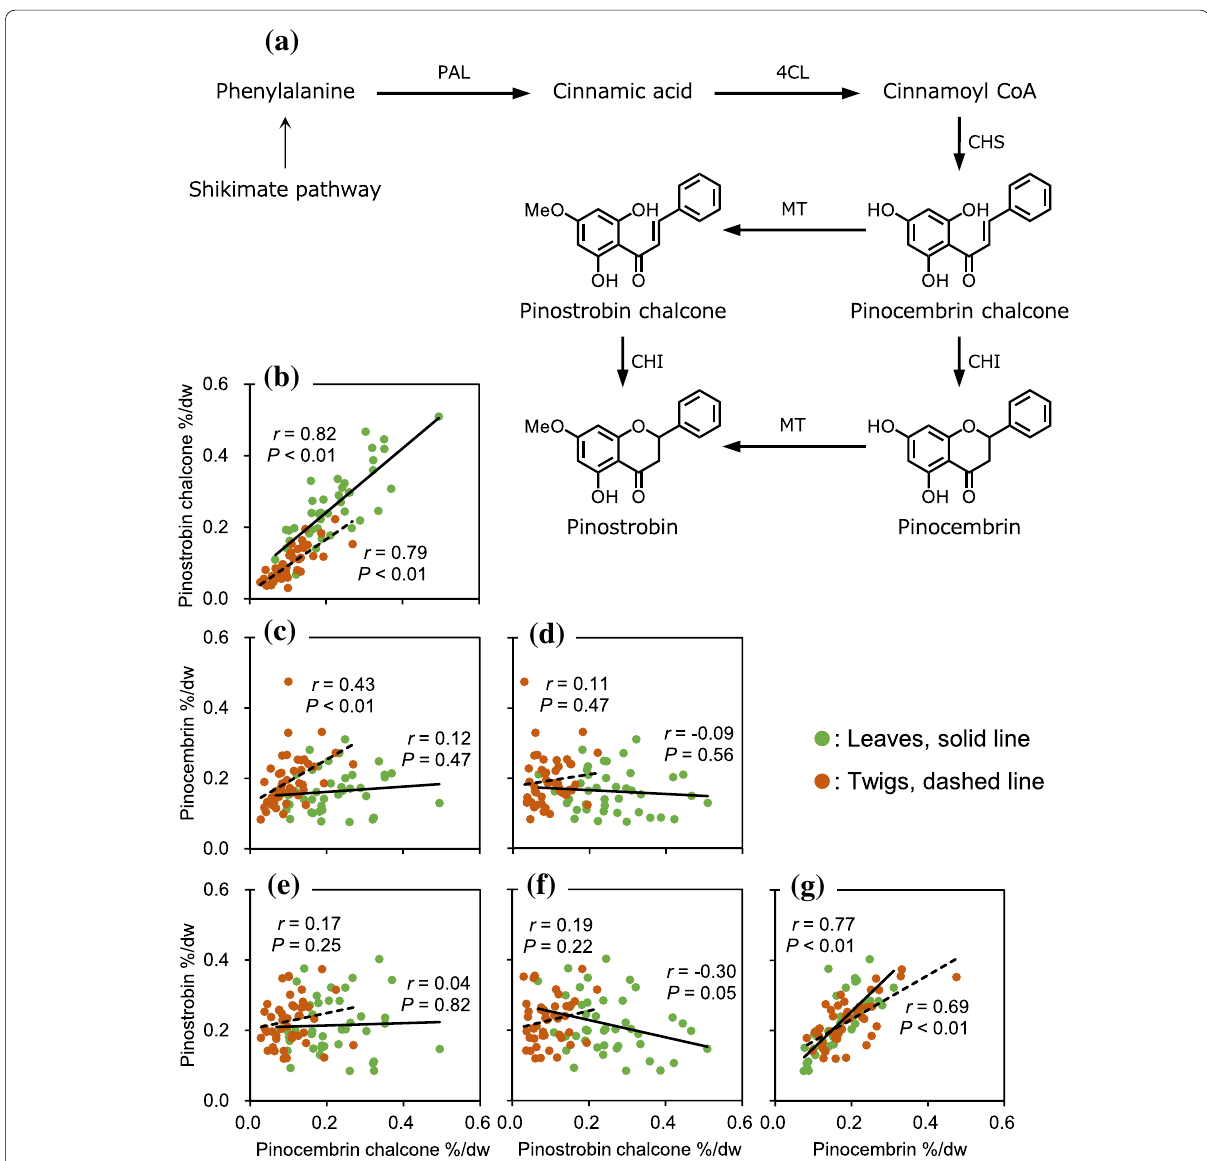
Fig. 9 General biosynthetic pathway for flavonoids and Pearson’s correlation coefficient and P value between each component. a General biosynthetic pathway of the identified flavonoids, b pinocembrin chalcone vs. pinostrobin chalcone, c pinocembrin chalcone vs. pinocembrin, d pinostrobin chalcone vs. pinocembrin, e pinocembrin chalcone vs. pinostrobin, f pinostrobin chalcone vs. pinostrobin, g pinocembrin vs. pinostrobin. r , correlation coefficient; P , P value; PAL phenylalanine ammonia lyase, 4CL 4-coumarate: CoA ligase, CHS chalcone synthase,